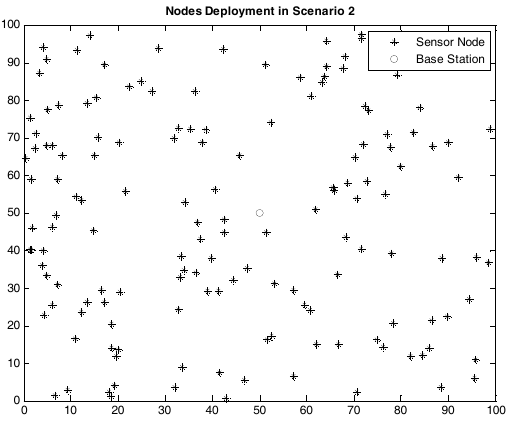
Figure 5. Nodes Deployment in Scenario 1.